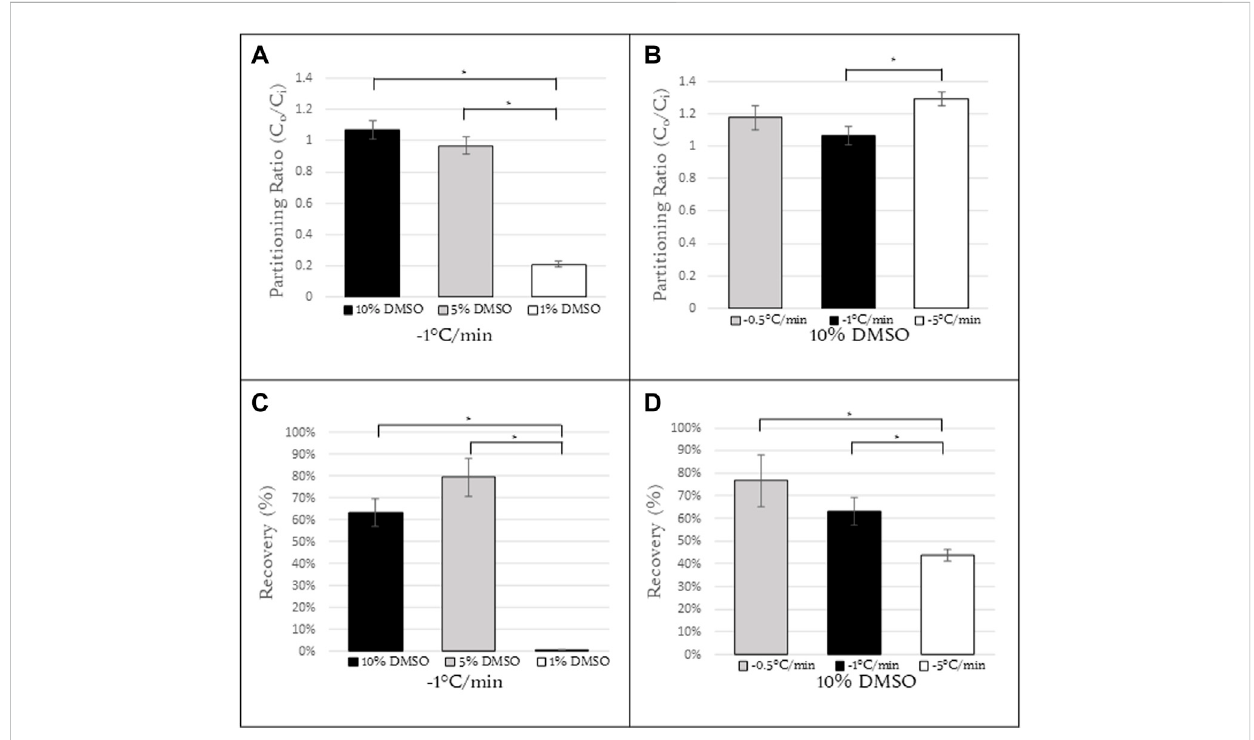
FIGURE 3 PartitioningratiosofJurkatcellsat (A) constantcoolingrateof1 ° C/minwithconcentrationsof10%,5%,1%DMSO(N=6,N=10,N=6,respectively)and (B) constantconcentrationof10%DMSOwithcoolingratesof0.5,1,and5 ° C/min(N=7,N=6,N=6,respectively). (C) RecoverycalculationsforJurkatcellswiththe same conditions as (A) . (D) Recovery calculations for Jurkat cells with the same conditions as (B) . N = 9 for all samples in (C,D) .*Indicates a p -value <